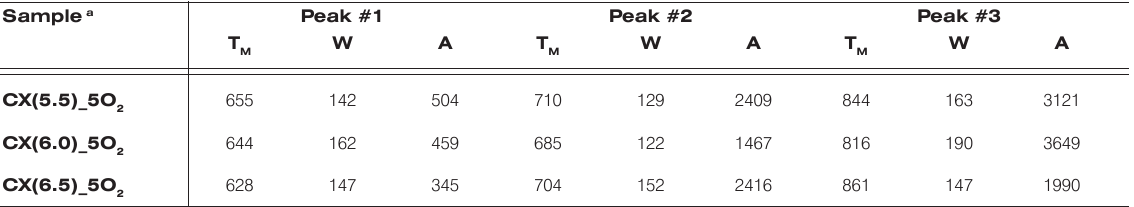
Figure 4. TEM images of the gold catalysts, together with the distribution of gold particle size. Table 5. Results of the deconvolution of CO-TPD spectra using a multiple Gaussian function. Sample